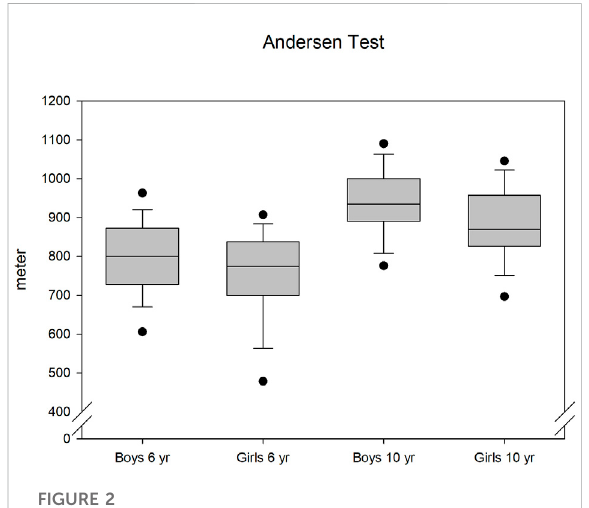
FIGURE 2 Development of running distance in the Andersen